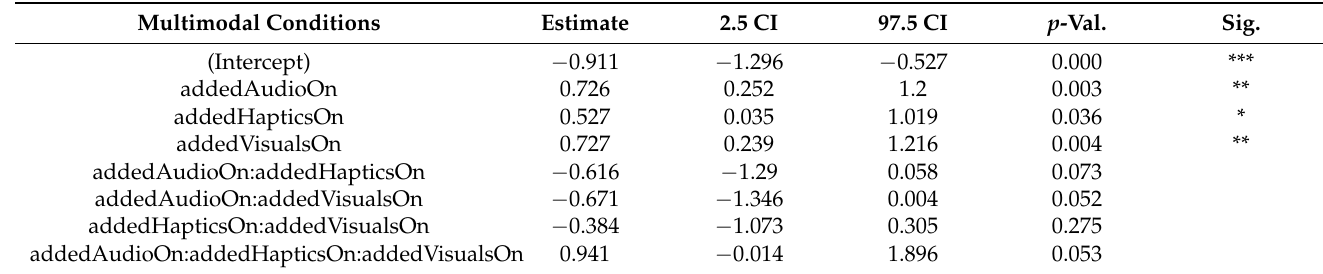
Table 2. Model parameter estimates.